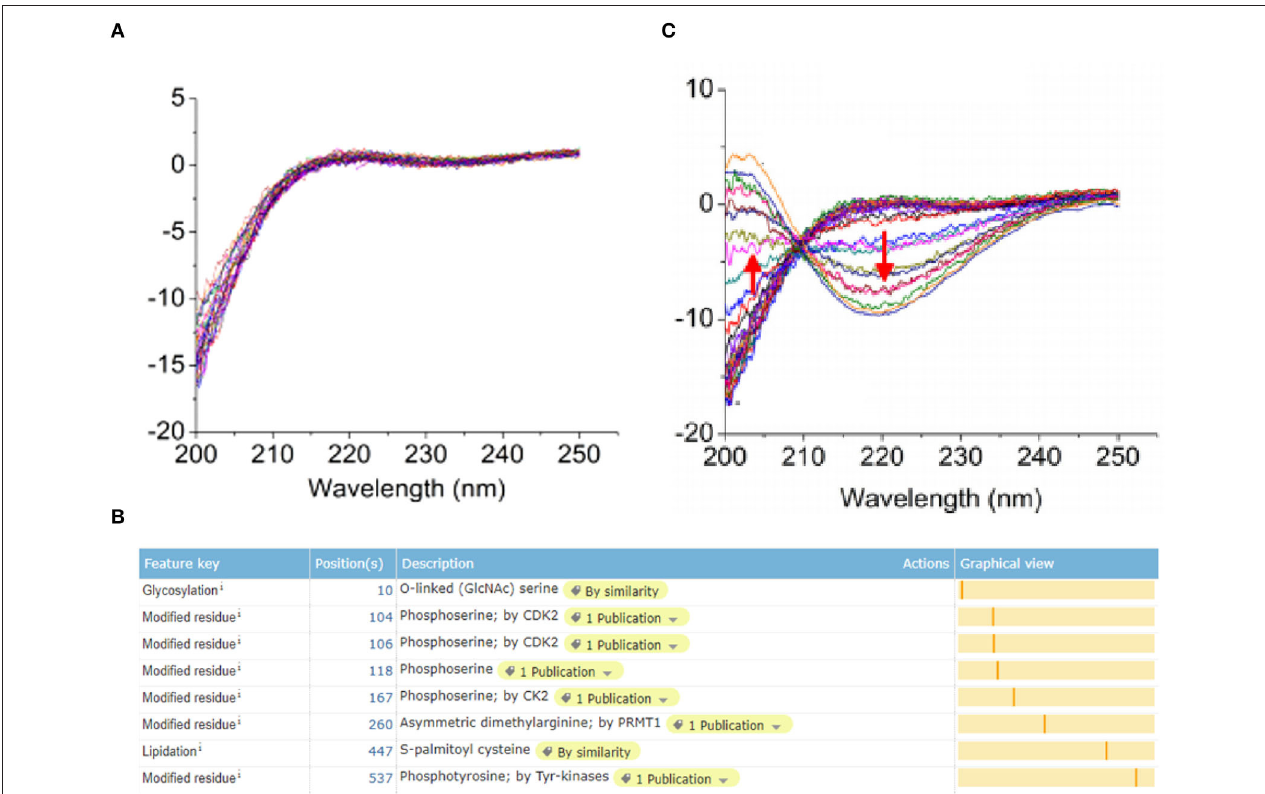
FIGURE 3 | Post-translational glycosylation modification of ER α induced by UGT1A1. The ER α protein expression in normal human breast epithelial cells has a modification site at the 10th amino acid with the O-GalNAc glycosylation (A) , which was in accord with the bio-information analysis based on the online software of Uniprot (https://www.uniprot.org/) (B) . However, the expression of ER α protein was present on the surface of TNBC cells with a low expression level, whereas the glycosylation site at the 10th amino acid site was UDP-GlcNAc glycosylation modification (C) .